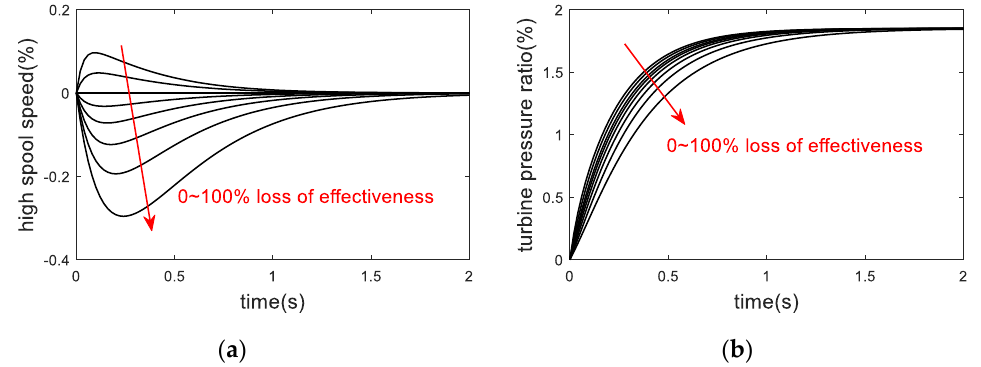
Figure 5. Fault tolerant control (FTC) result of sliding mode control (SMC) design-controlled variables. ( a ) n h ( b ) π t